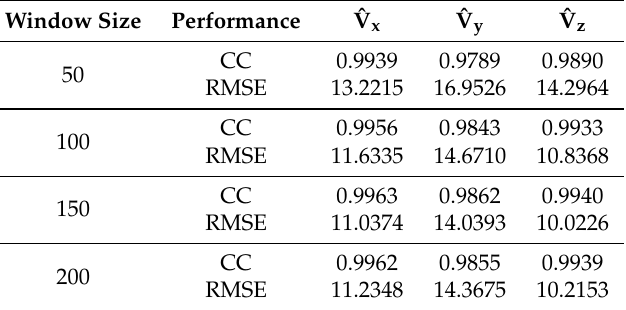
Table 2. RMSE and CC between measured and derived Frank XYZ